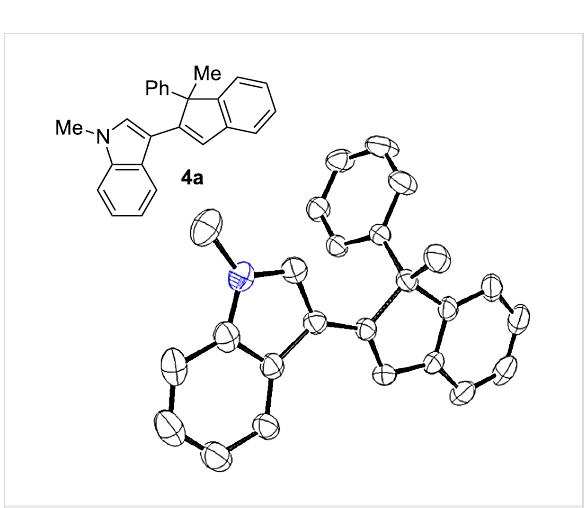
Figure 1: ORTEP diagram for 4a . Ellipsoids are shown at 30% level (hydrogen atoms are omitted for